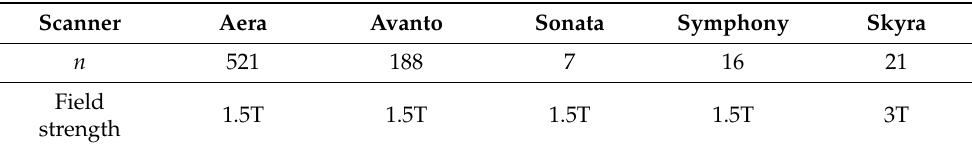
Table 1. Distribution of the examinations to the different MR